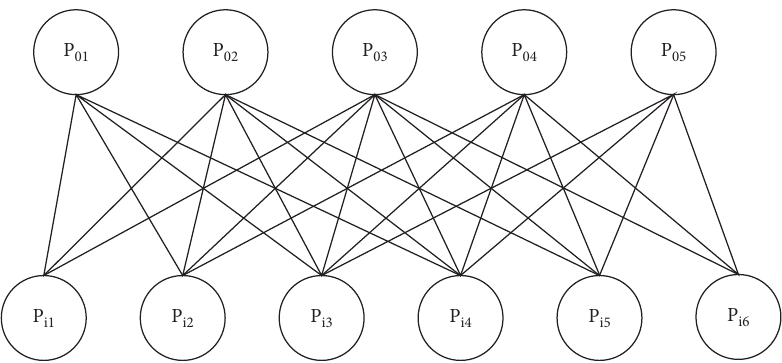
Figure 3: The bipartite graph formed by the pairing of plane sets in the two